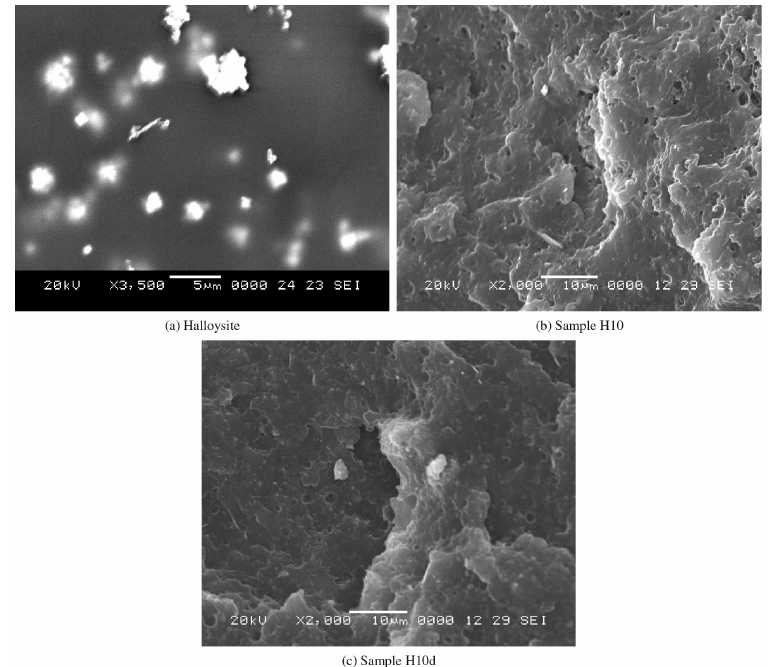
Figure 4. SEM images: (a) Pure halloysite, (b) Sample H10 (without DCP), (c) Sample H10d (with 0.5 w/w DCP), both containing 10% w/w halloysite. Table 4. Results obtained by DMA of the composites and hiPP.